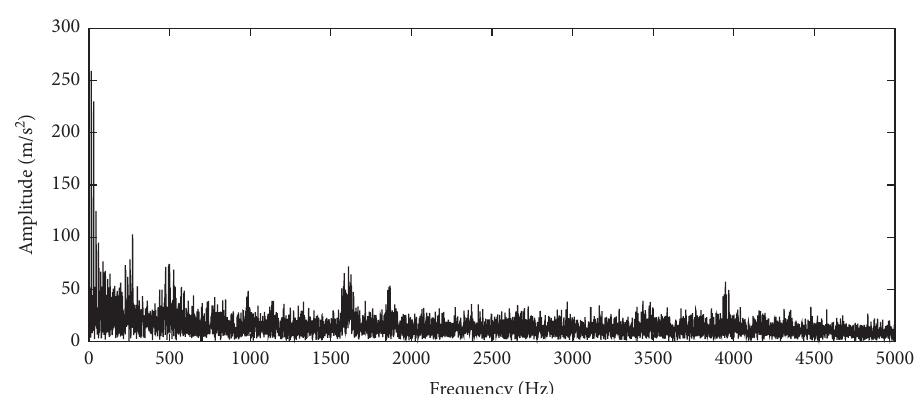
Figure 22: Envelope spectrum analysis for data of sample